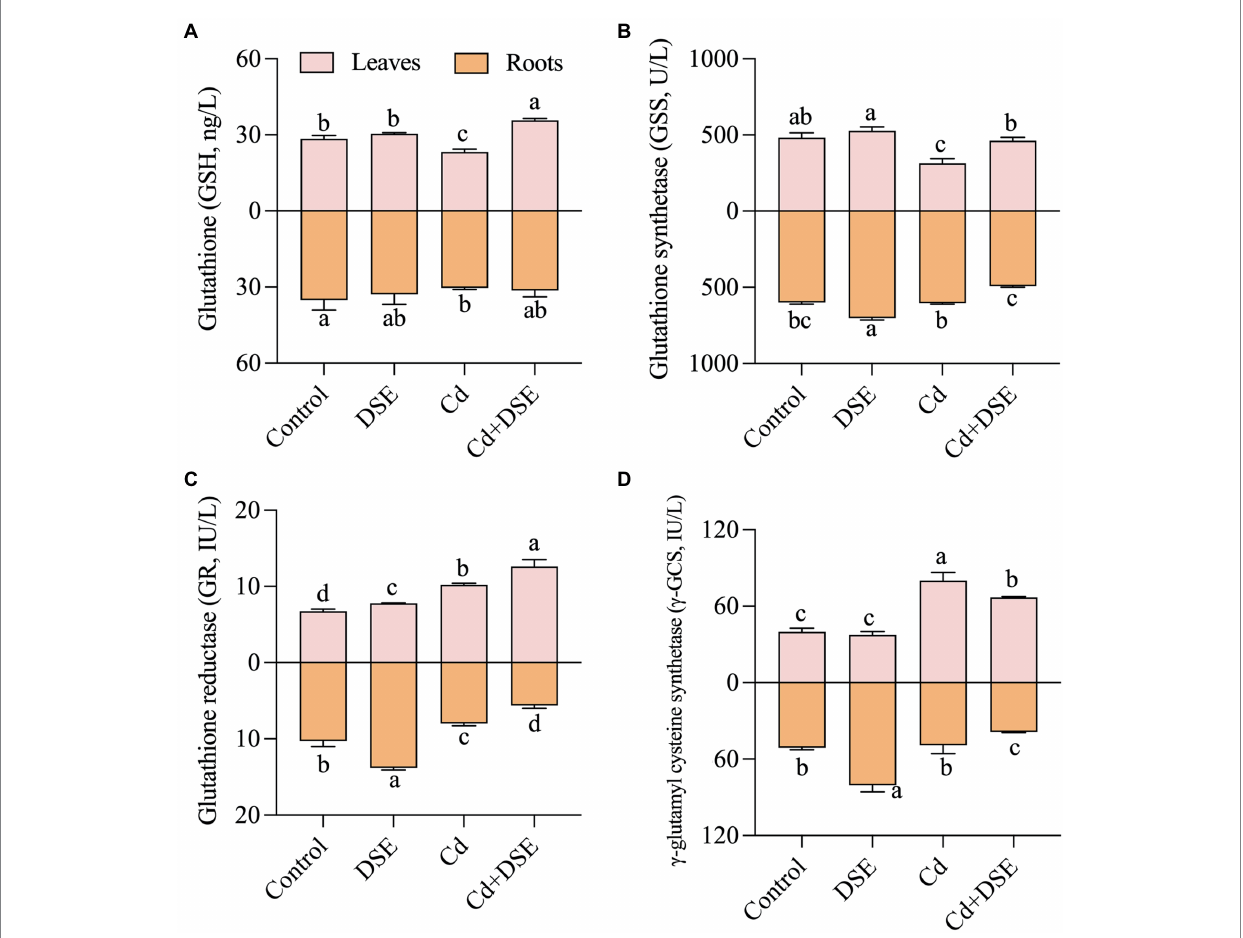
FIGURE 4 Responses of sulfhydryl compounds of maize leaves and roots to E. pisciphila inoculation and Cd stress. A : glutathione, B : glutathione synthetase, C : glutathione reductase; D : γ -glutamyl cysteine synthetase. Data were mean values ( n = 3) and error bars represent the standard deviation. Different letters indicate significant differences between